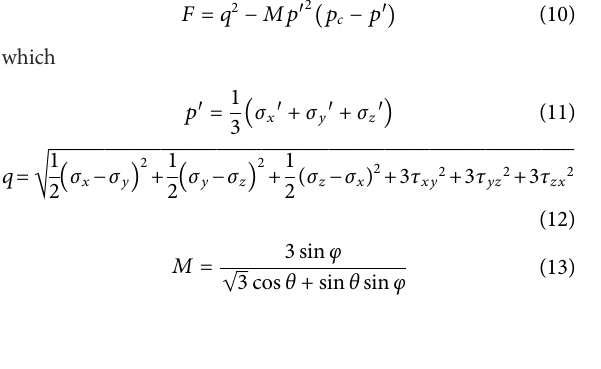
MC and DP yield surfaces in the π plane.